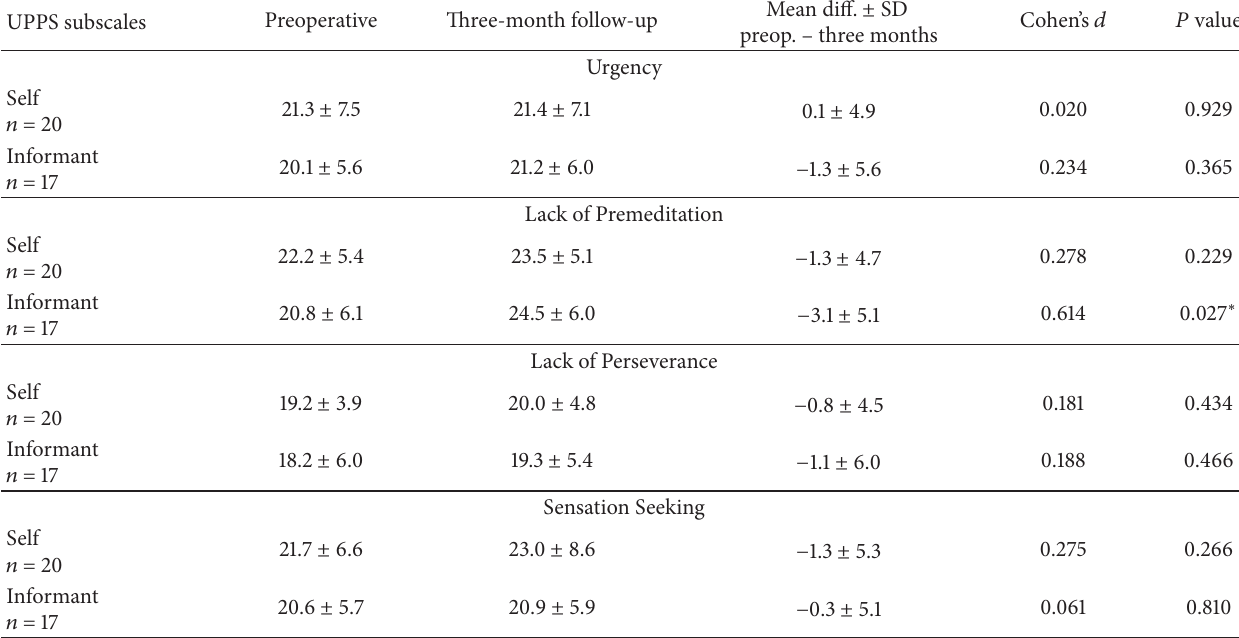
Table 4: Self-reported and informant-reported UPPS scores preoperatively and at three-month follow-up. UPPS